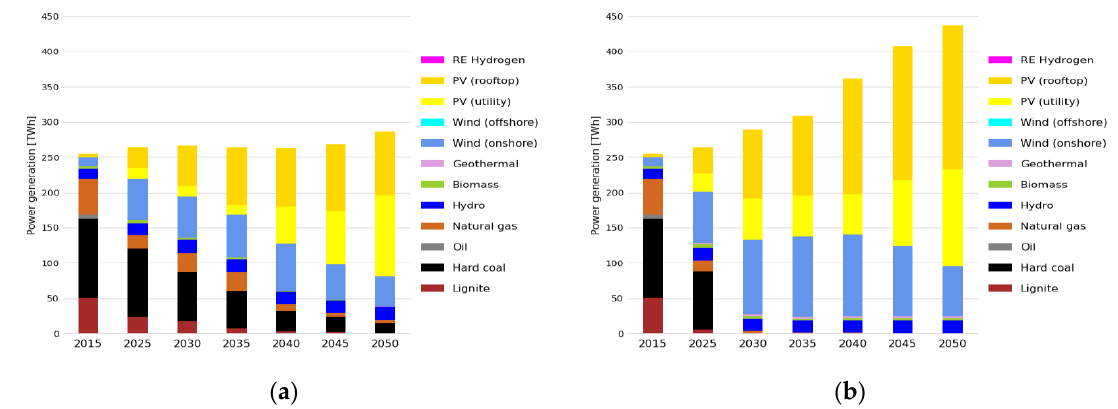
Figure 1. Development of electricity generation fuel mix over time, aggregated results for total Australia, represented for different scenarios: ( a ) Low Mitigation Effort (LME); ( b ) P1.5 °C.